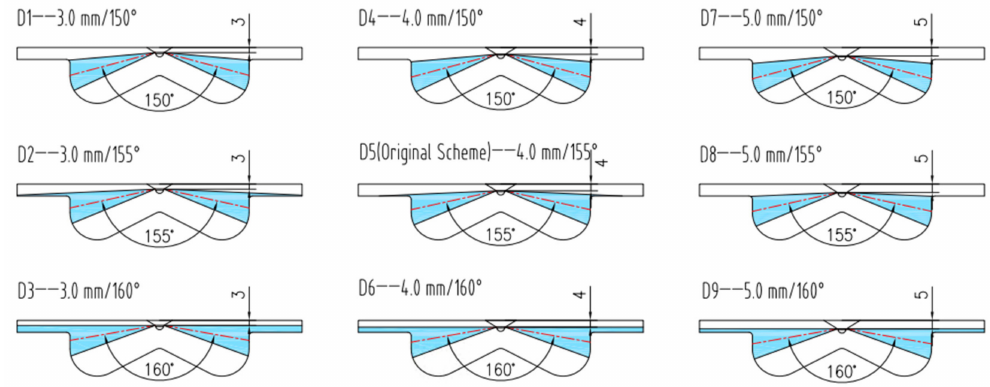
Figure 34. Different layout of injectors and spray